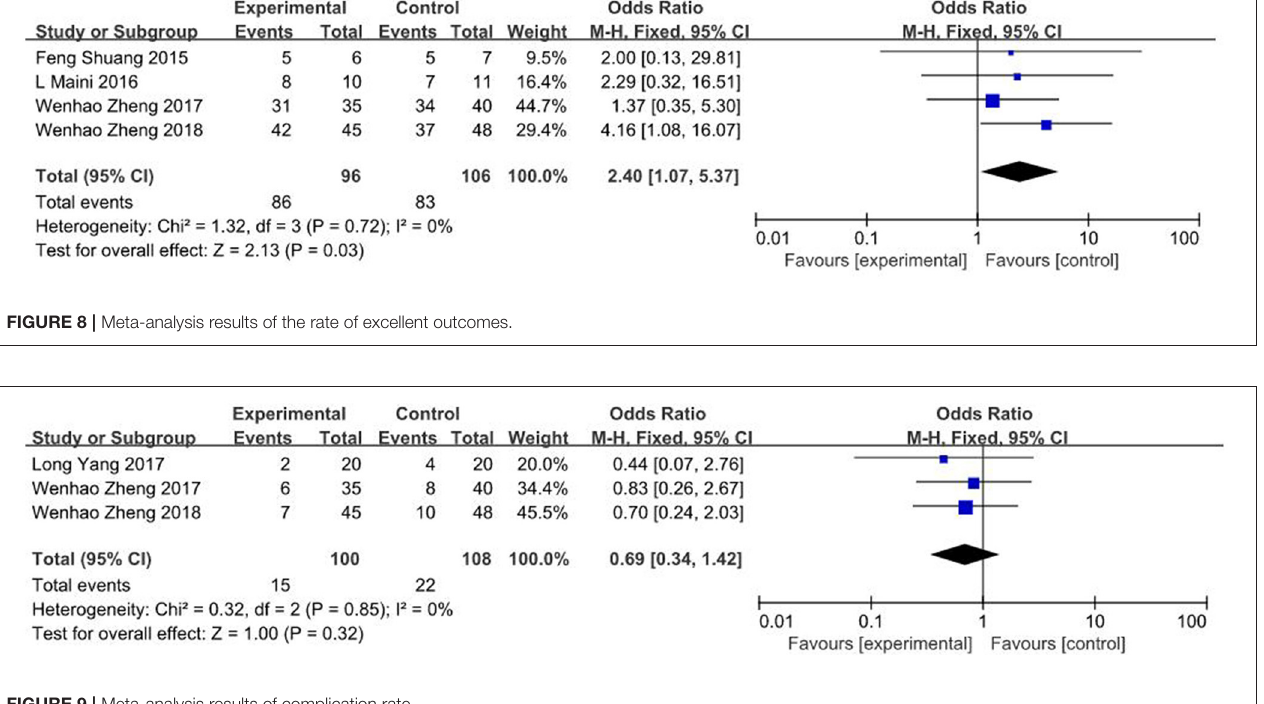
results were not analysed in the current study due to insufficient number of included